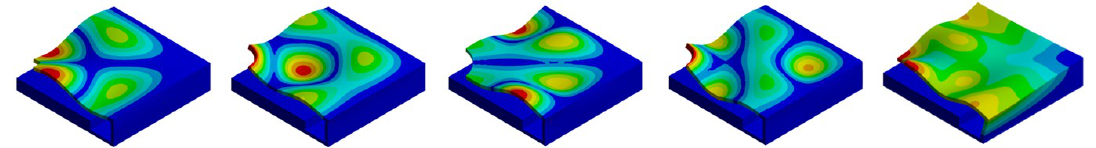
Figure 18. Four package modes for case (a): 6th mode shape at 81.32 kHz ( left ), 7th mode shape at 104.13 kHz ( center-left ), 8th mode shape at 104.29 kHz ( center-right ), 16th mode shape at 157.53 kHz ( right ).